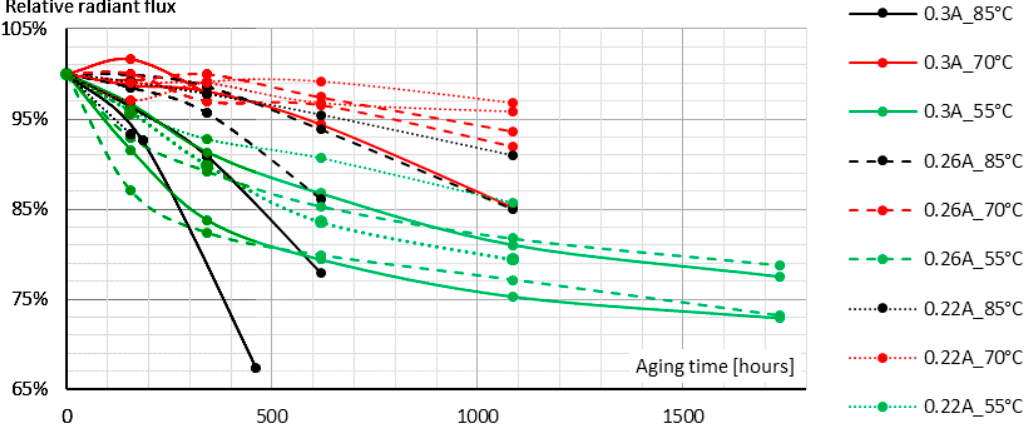
Figure 15. The attained total radiant flux maintenance results of the mid-power blue LEDs, sorted by case temperature and forward current.